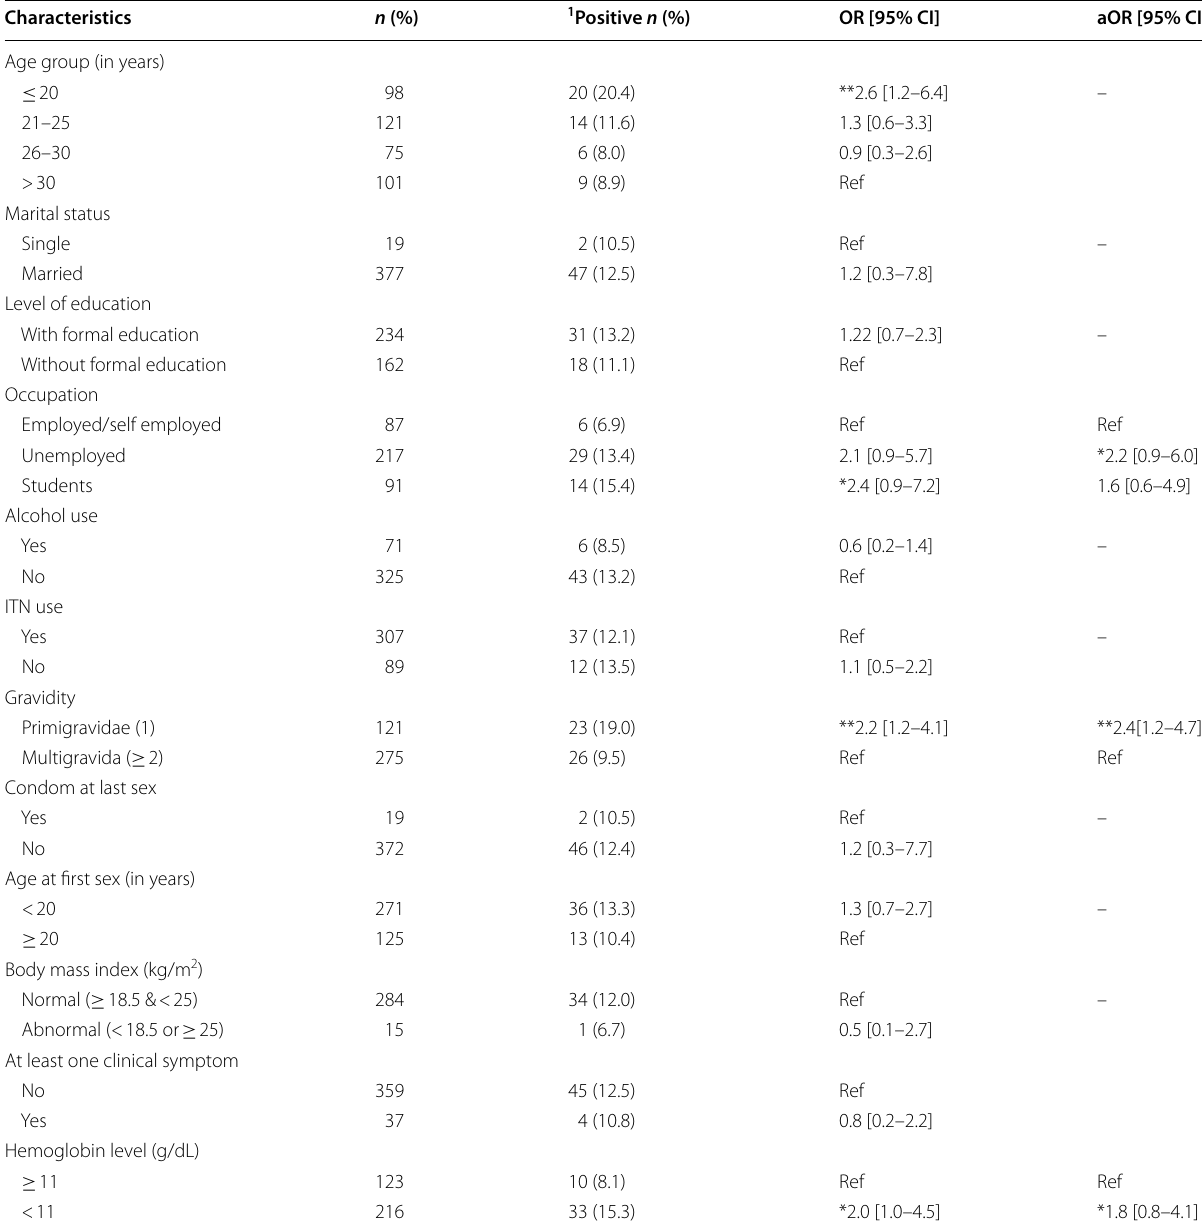
Table 4 Univariate and multivariate analyses of potential risk factors for malaria and curable STI/RTI coinfection among first ANC attendees ( n 402) in the Yako health district, rural Burkina =